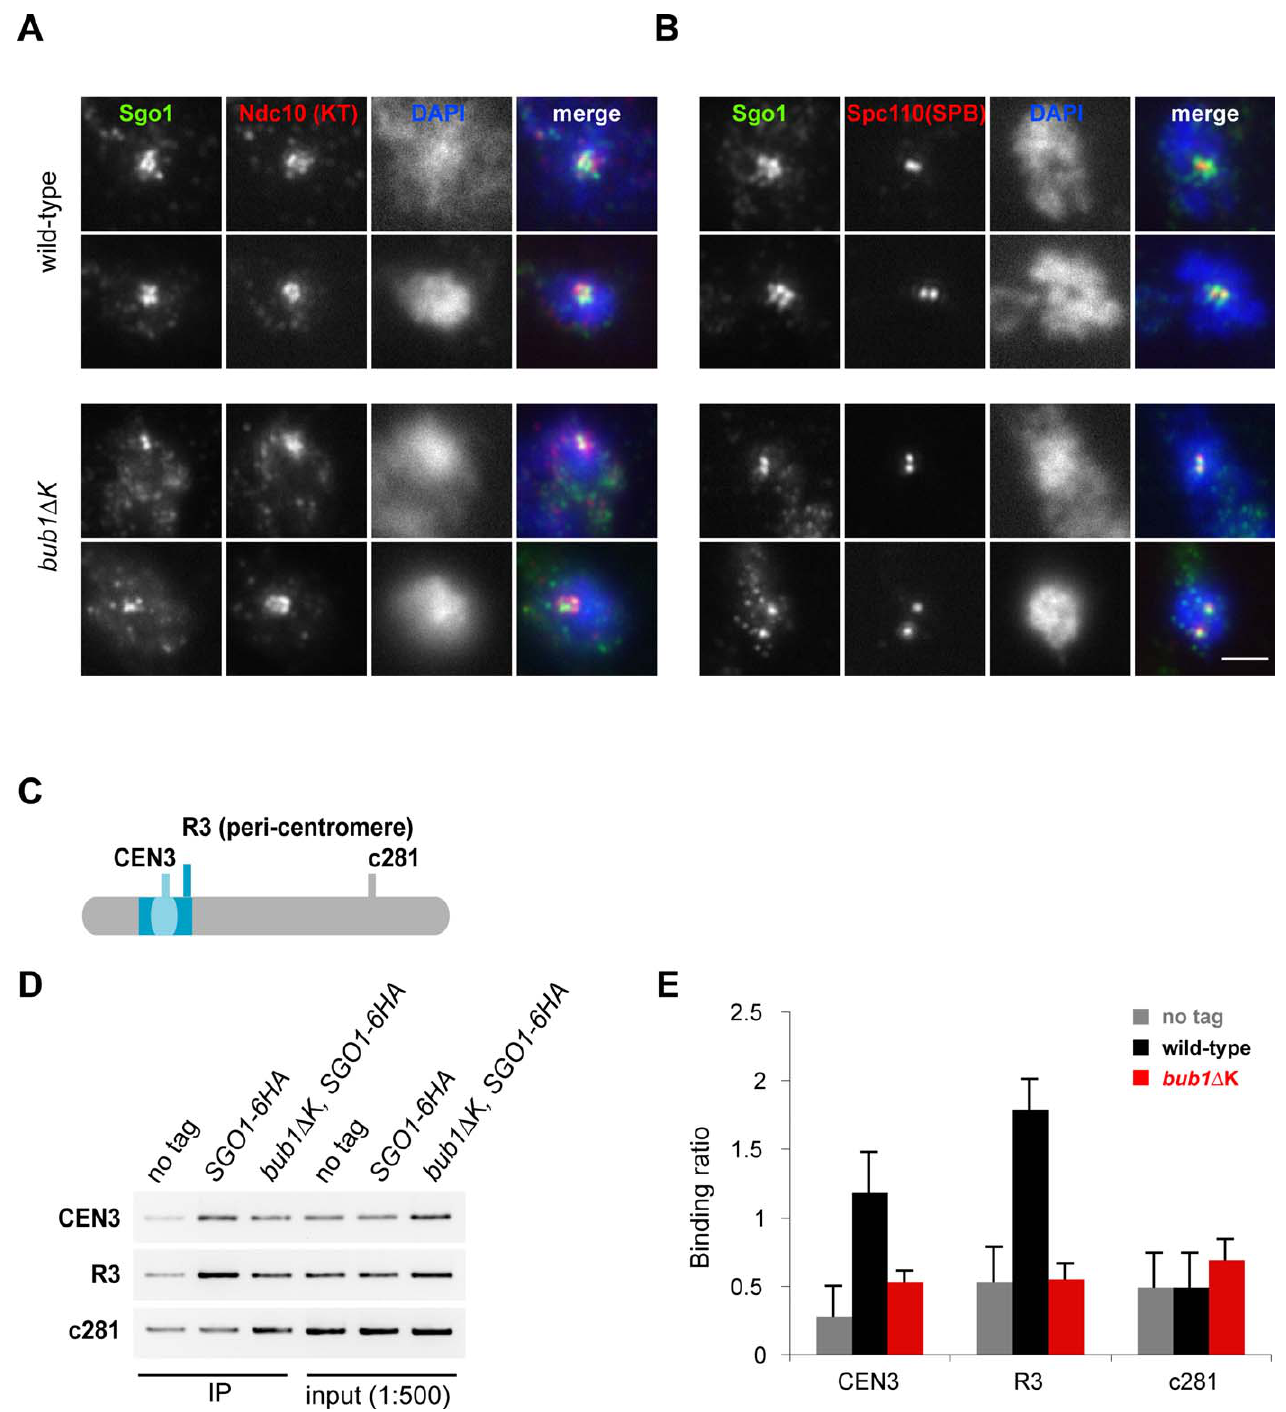
Figure 3. Bub1 Kinase Domain Is Necessary for Accurate Sgo1 Localisation to Kinetochores (A) Wild-type (AMY1110) and bub1 D K (JF038) strains containing Sgo1-9Myc and Ndc10-6HA (to mark the kinetochores) were arrested in metaphase with 15 l g/ml nocodazole and 30 l g/ml benomyl at 23 8 C for 3 h. Chromosome spreads were performed and stained with a -myc antibody (CM-100), a -HA antibody (HA11), and DAPI to recognize the DNA. Spreads with clear Ndc10-6HA staining were categorized as showing colocalization with Sgo1-9myc only if they contained multiple ( . 2) overlapping foci. Fifty spreads per strain were analysed. (B) Sgo1-9myc colocalises with the SPB in the bub1 D K mutant. Spreads were prepared as in (A) and stained with a -myc antibody, anti-Spc110 antibody to detect SPBs, and DAPI. Scale bar represents 2 l m. (C) Schematic of primers sets for Sgo1-6HA ChIP analysis showing the CEN3, centromeric region; R3, pericentromeric region; and c281, the negative arm region. (D) PCR on ChIPs of ‘‘ no tag ’’ (KH186), Sgo1-6HA (AMY209), and bub1 D K, Sgo1-6HA (JF211) strains arrested with 15 l g/ml nocodazole and 30 l g/ml benomyl at 23 8 C for 3 h, showing reduced Sgo1p levels associated with CEN3 and R3 regions in the bub1 D K mutant compared to wild type. (E) The graph shows quantification of the ChIP data from the ‘‘ no tag ’’ (KH186), wild-type (AMY209), and bub1 D K (JF211) strains. The ‘‘ binding ratio ’’ was calculated as a ratio of the ChIP PCR signal to the PCR signal from a 1:500 diluted input fraction. The error bars indicate standard deviation (SD) of the mean from five different PCR reactions from two separate experiments. doi:10.1371/journal.pgen.0030213.g003 PLoS Genetics |